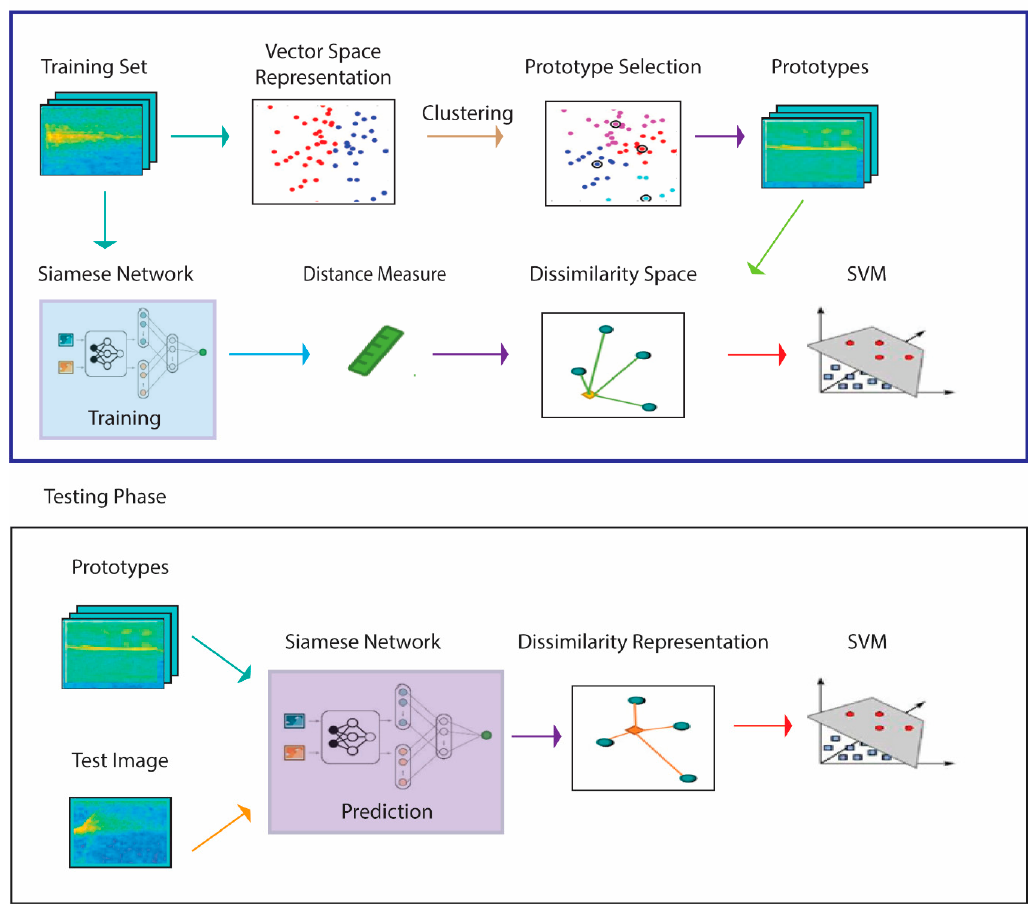
Figure 1. Generalized schematic of the proposed approach.